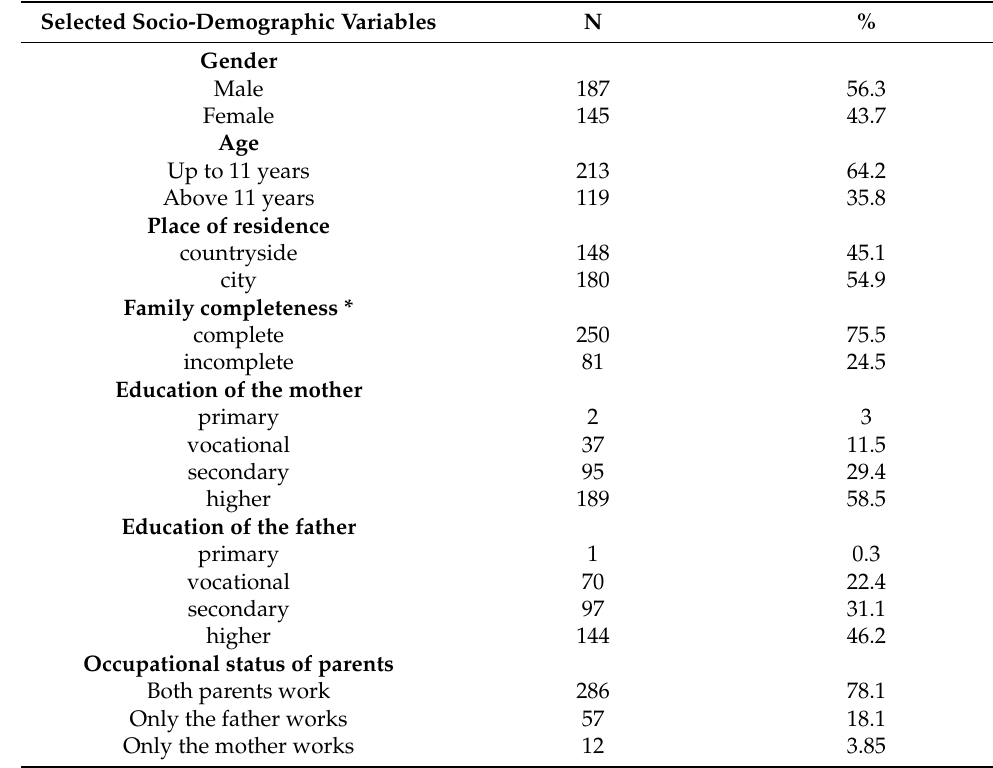
Table 1. Socio-demographic characteristics of the study group. Selected Socio-Demographic